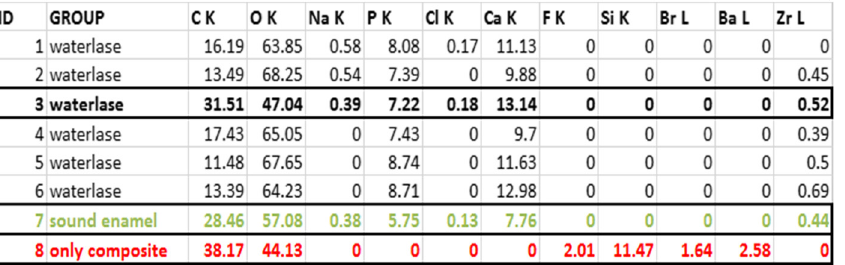
Figure 2. The atomic composition of the samples n1 to n8 , with sample n.3 sharing similar atomic concentrations with the ‘sound enamel’ sample.